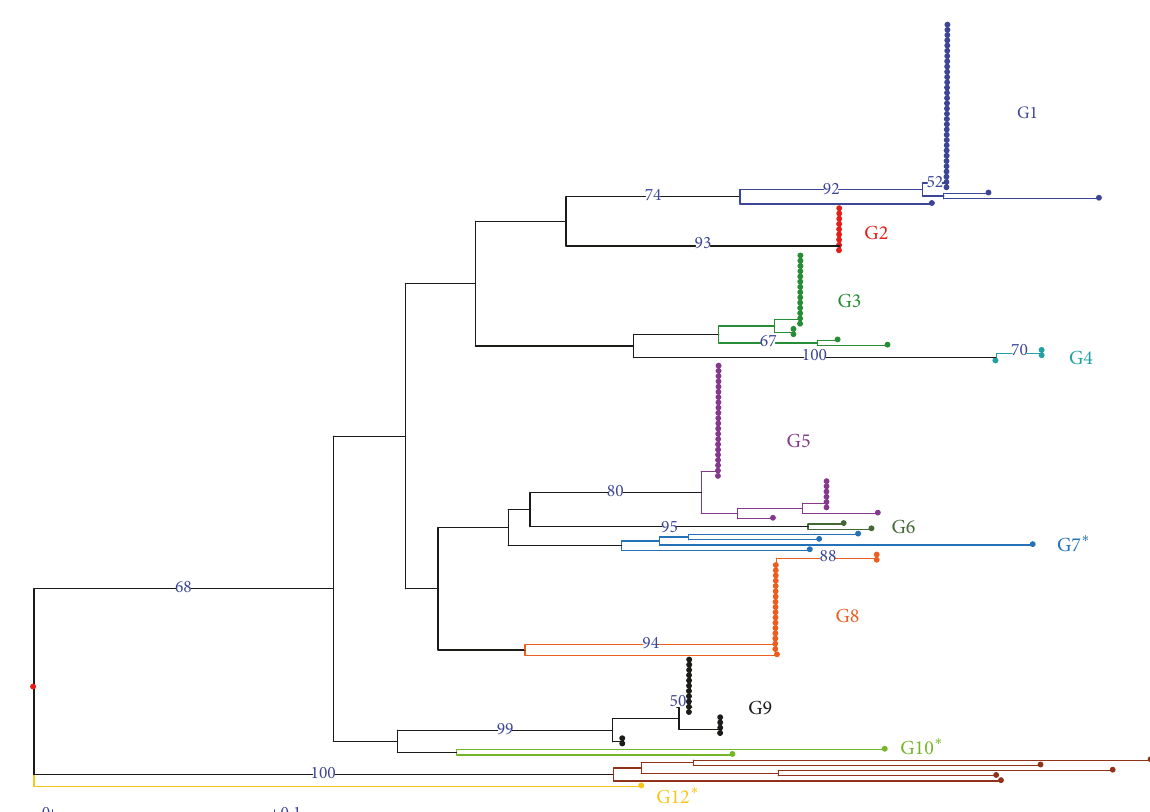
Figure 5: Diversity tree for the 146 plants analyzed at the Pichilingue collection in